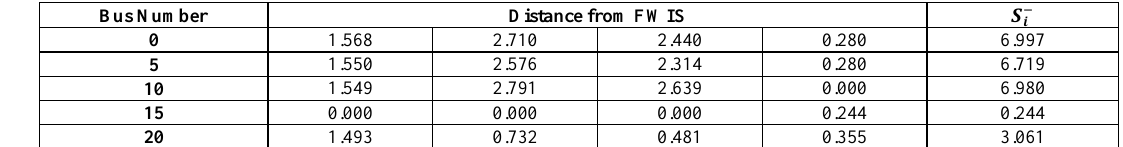
Table 14. Distance from FWIS